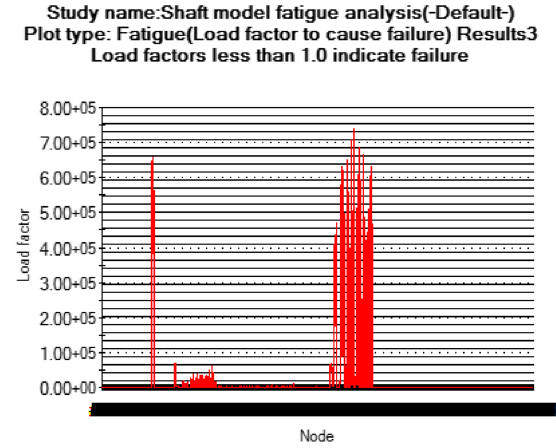
Figure 25. Simulation graph for fatigue load.